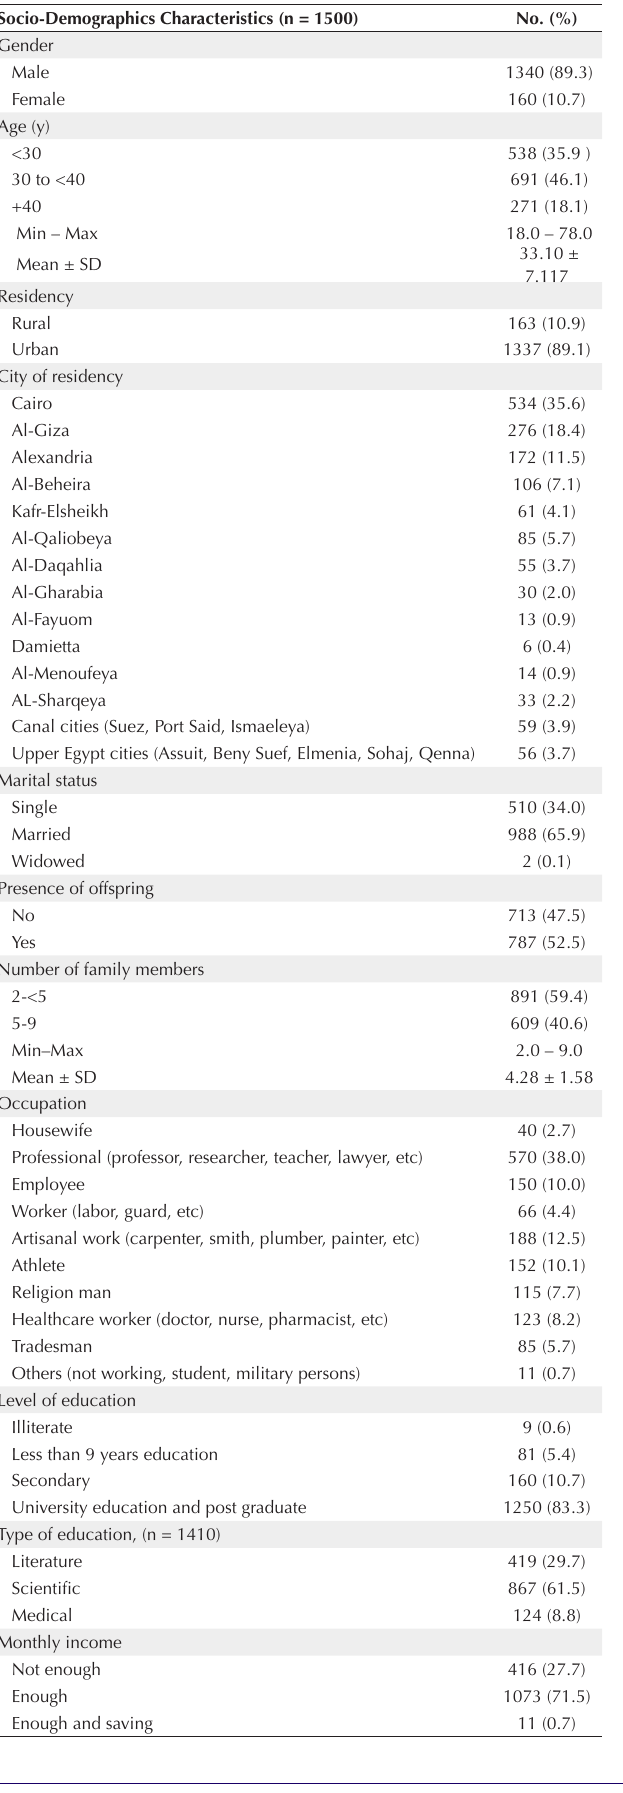
Table 2. Distribution of the Travelers at Cairo International Airport According to the Journey Details Journey details (n =